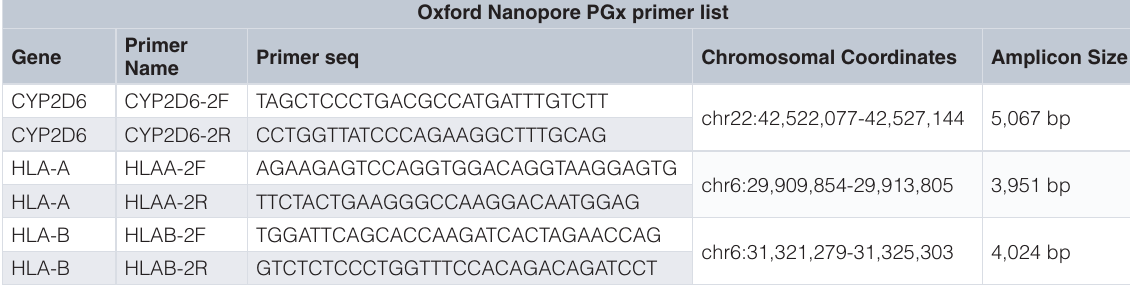
Table S1. Primer sequences and amplicon lengths for HLA-A , HLA-B and CYP2D6